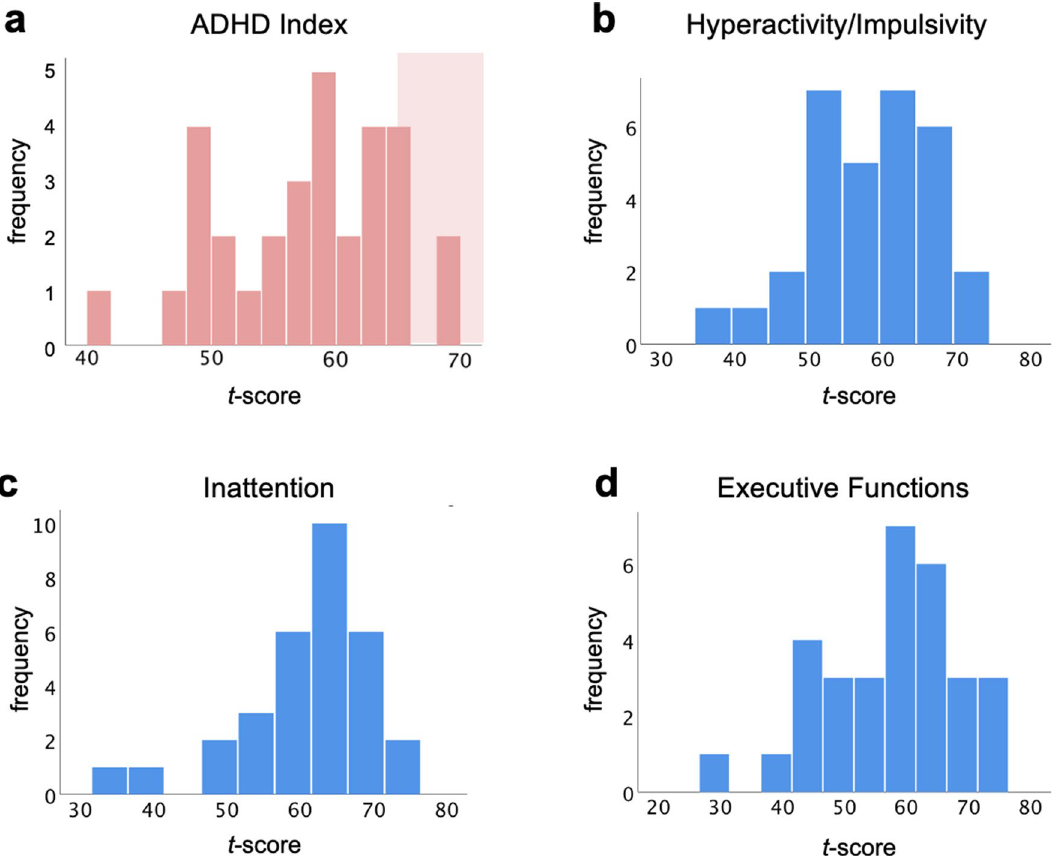
Figure 2. Distributions of participants’ scores on the Conners 3 Scales for Attention and Behavior. ( a) Frequency histogram of Conners 3 ADHD Index t -scores. t -scores ≥ 65 are interpreted as elevated scores 39 and marked by a light red shading in the background. ( b – d ) Frequency histograms of t -scores of Conners 3 sub- scales for Inattention, Hyperactivity/Impulsivity, and Executive Functions,